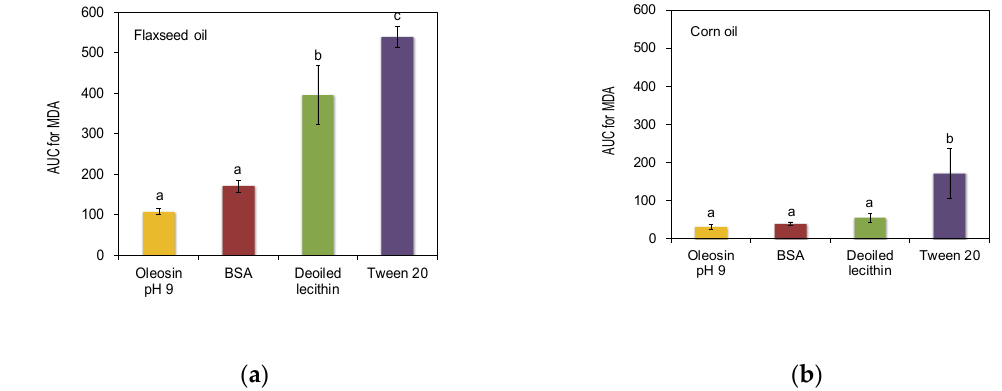
Figure 6. Oxidative stability for ( a ) flaxseed oil emulsions ( b ) corn oil emulsions stabilized by rapeseed protein extracted at pH 9, bovine serum albumin (BSA), de-oiled lecithin and Tween 20 expressed as AUC for malondialdehyde (MDA) concentrations (mg MDA/L emulsions). Data is an average of four measurements of two emulsion replicates for each oil. Different letters indicate significant differences within each figure, p < 0.05.